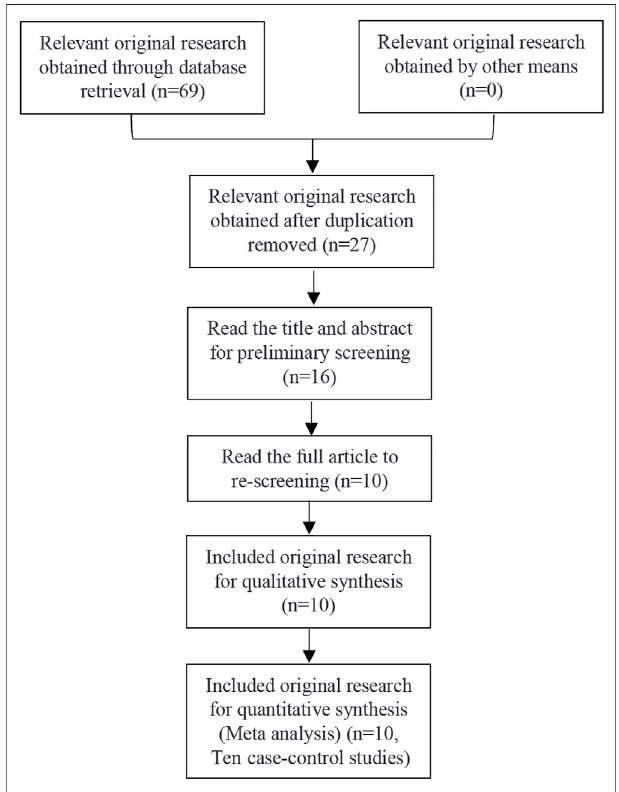
FIGURE 1 | Article screening process and